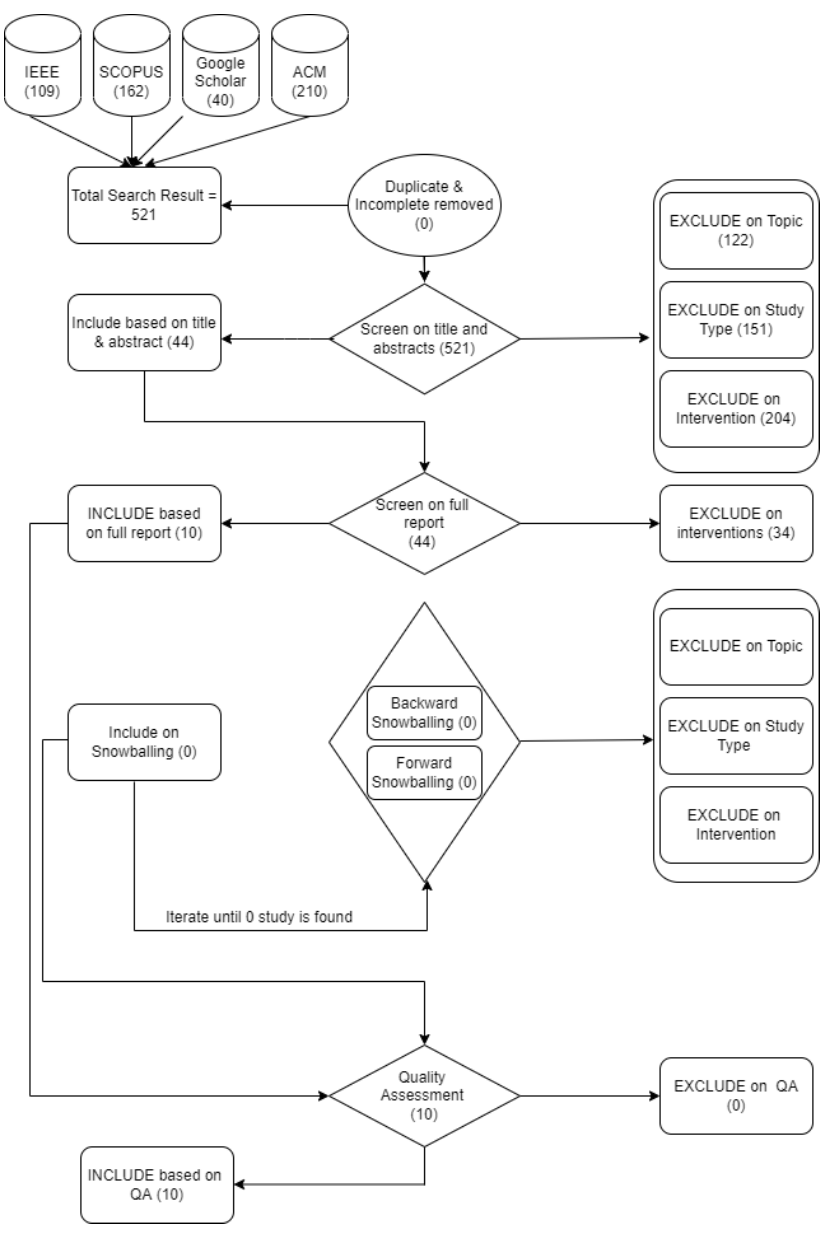
Figure 1. Study Selection